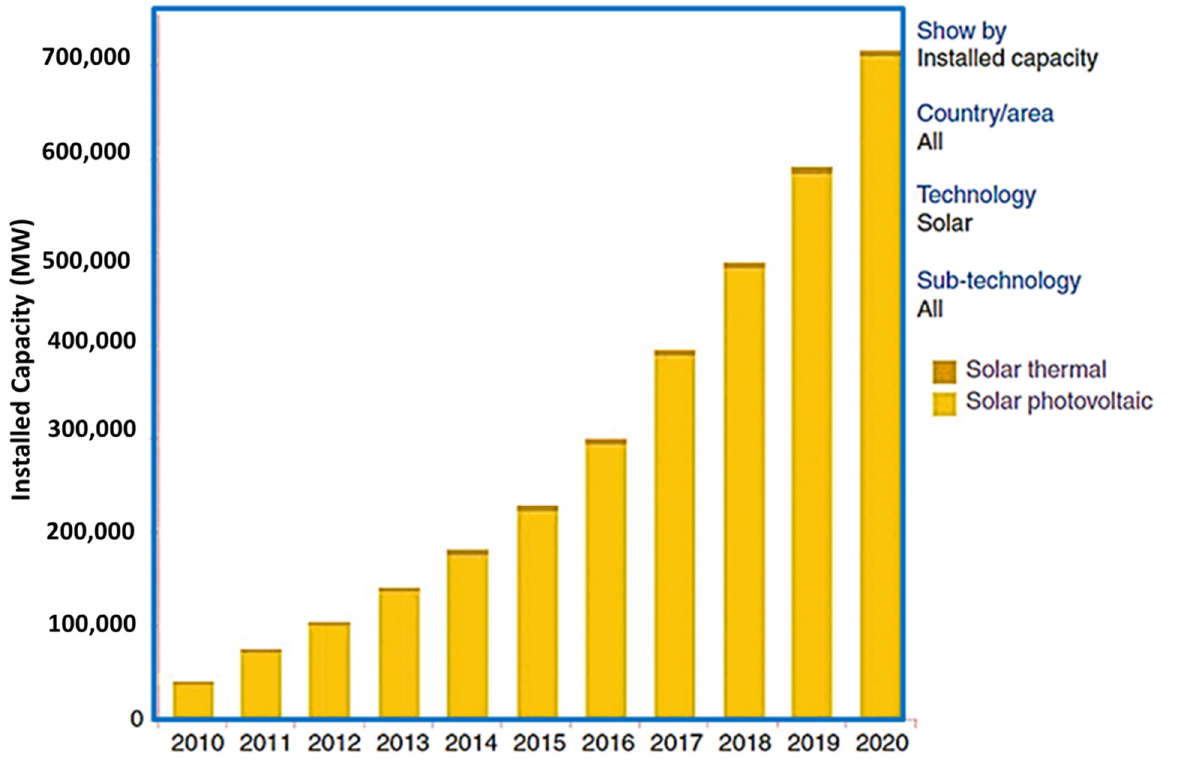
Figure 8. Installation capacity of solar energy worldwide [138], open access.